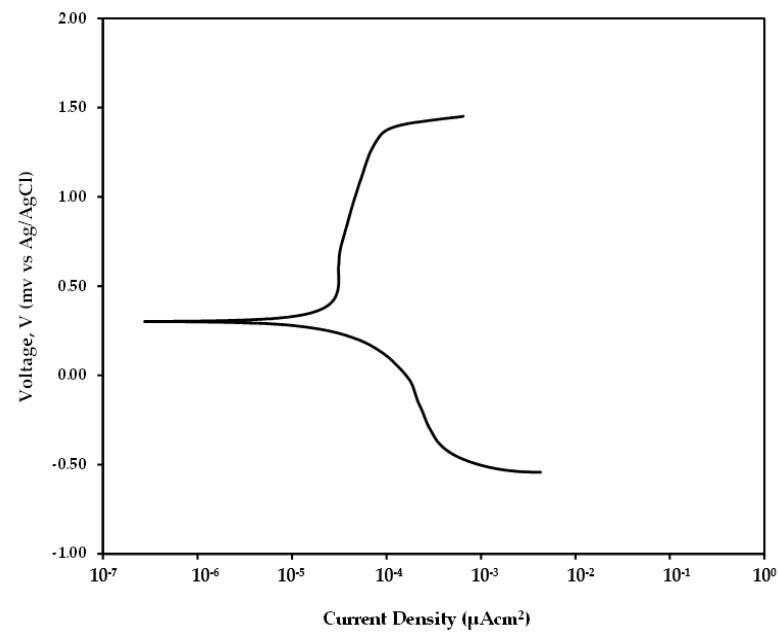
Figure 8. Tafel curve obtained for mild steel sample after 4 h immersion.